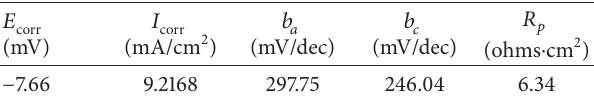
Table 2: Electrochemical parameters obtained from polarization curve for stainless steel 309 in molten salts 50mol% V SO at 700 ∘ Na 2 4